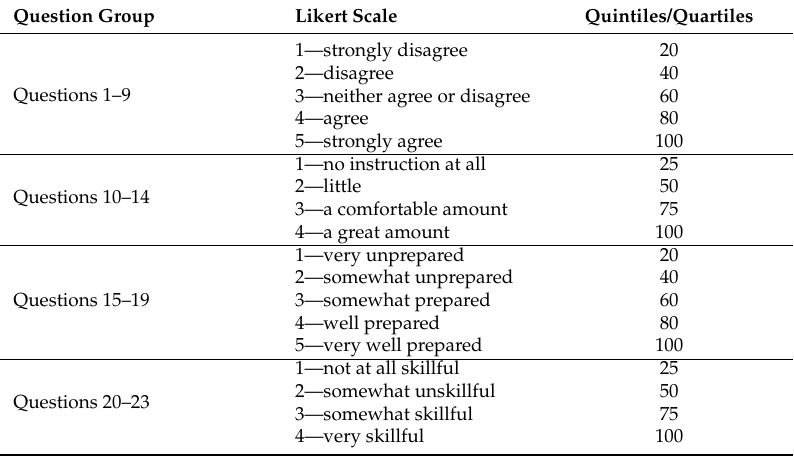
Table 1. Likert score transformation into quintiles or quartiles a